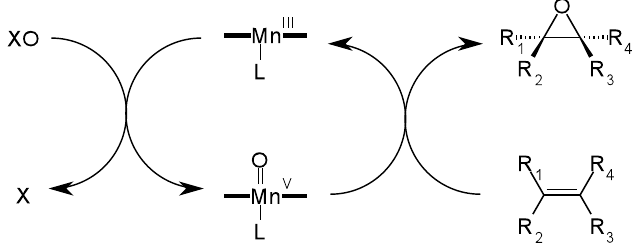
Figure 3. Oxygen-rebound mechanism for the Mn(salen)-catalyzed epoxidation of alkenes. The structure of the salen catalyst is simplified by a horizontal bar around the Mn atom; XO represents the terminal oxidant; and L is a generic axial